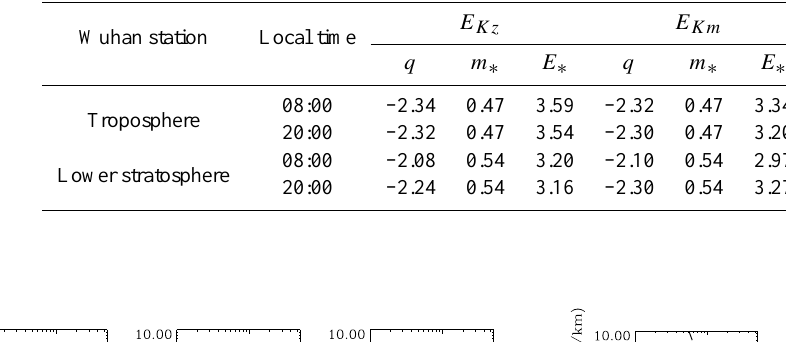
Table 3. Parameters of vertical wave number spectra for GWs over Wuhan station at different local times.